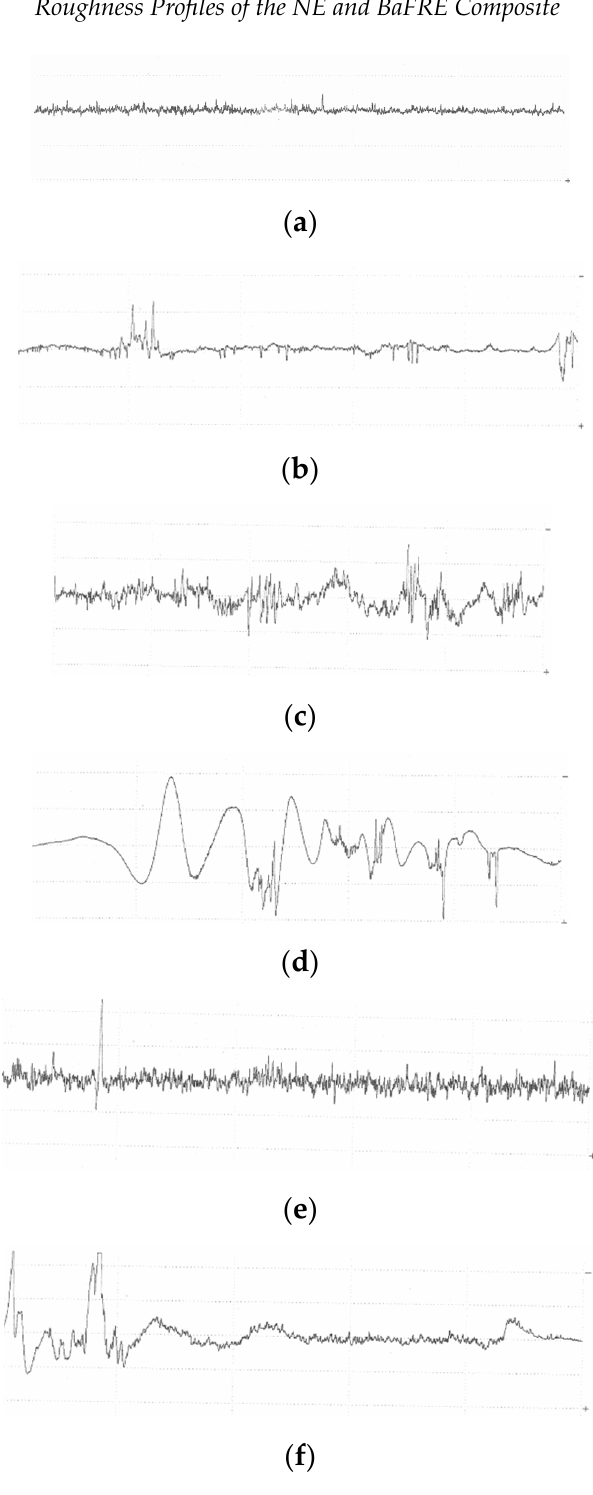
Figure A8. Composite surface roughness profile for different fibre orientations (AP and P) and neat epoxy under 30 N load at 3.96 m/s of sliding velocity. ( a ) NE-before, Ra = 0.126 µ m. ( b ) NE-after, Ra = 0.221 µ m. ( c ) AP-before, Ra = 0.578 µ m. ( d ) AP-after, Ra = 1.122 µ m. ( e ) P-before, Ra = 0.386 µ m. ( f ) P-after, Ra = 0.677 µm.